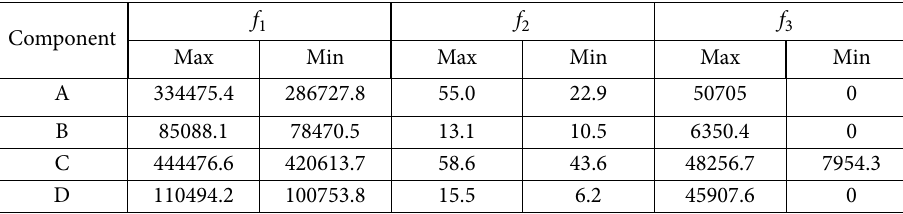
Table 18. Max-min objective values for the components